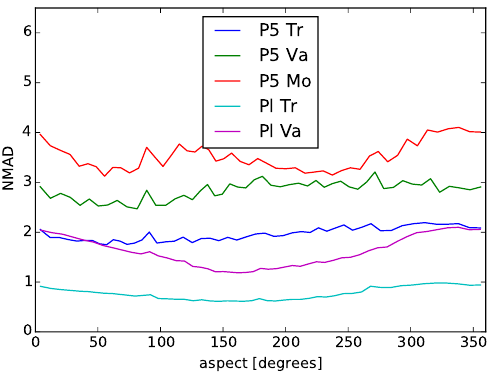
Figure 7: Dependence of height error based on estimated lower bound of energy A lb .